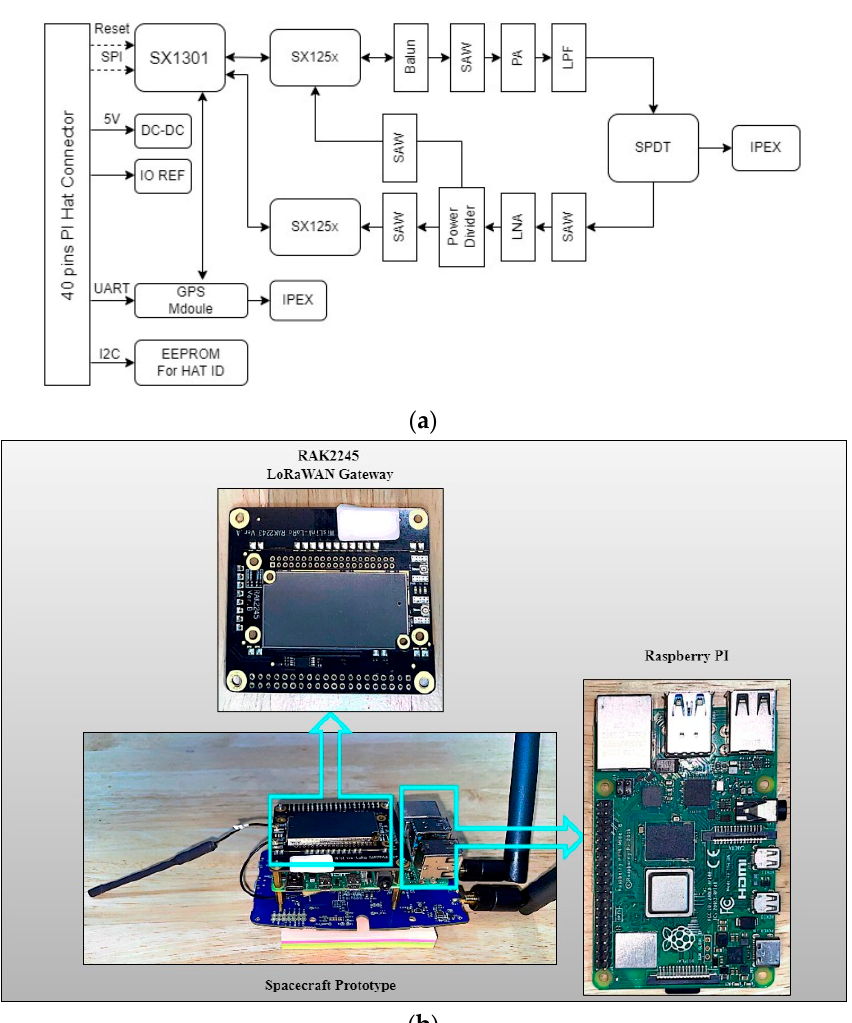
Figure 6. ( a ) Block diagram [26] and ( b ) module of LoRaWAN gateway together with the Raspberry Pi used in this study.